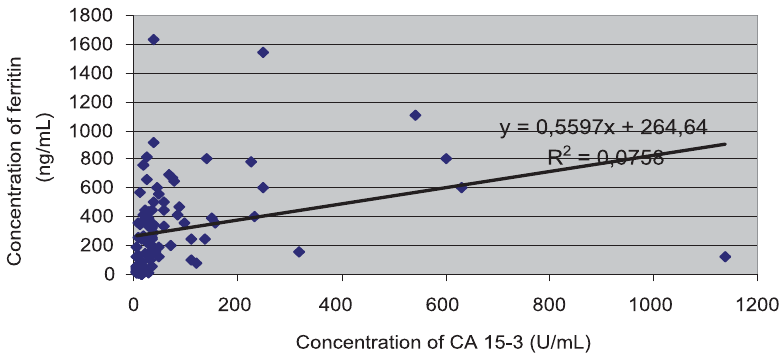
FIGURE 4. Comparison of CA 15-3 and CEA in serum measured by Architect CMIA. The correlation coef fi cient r =